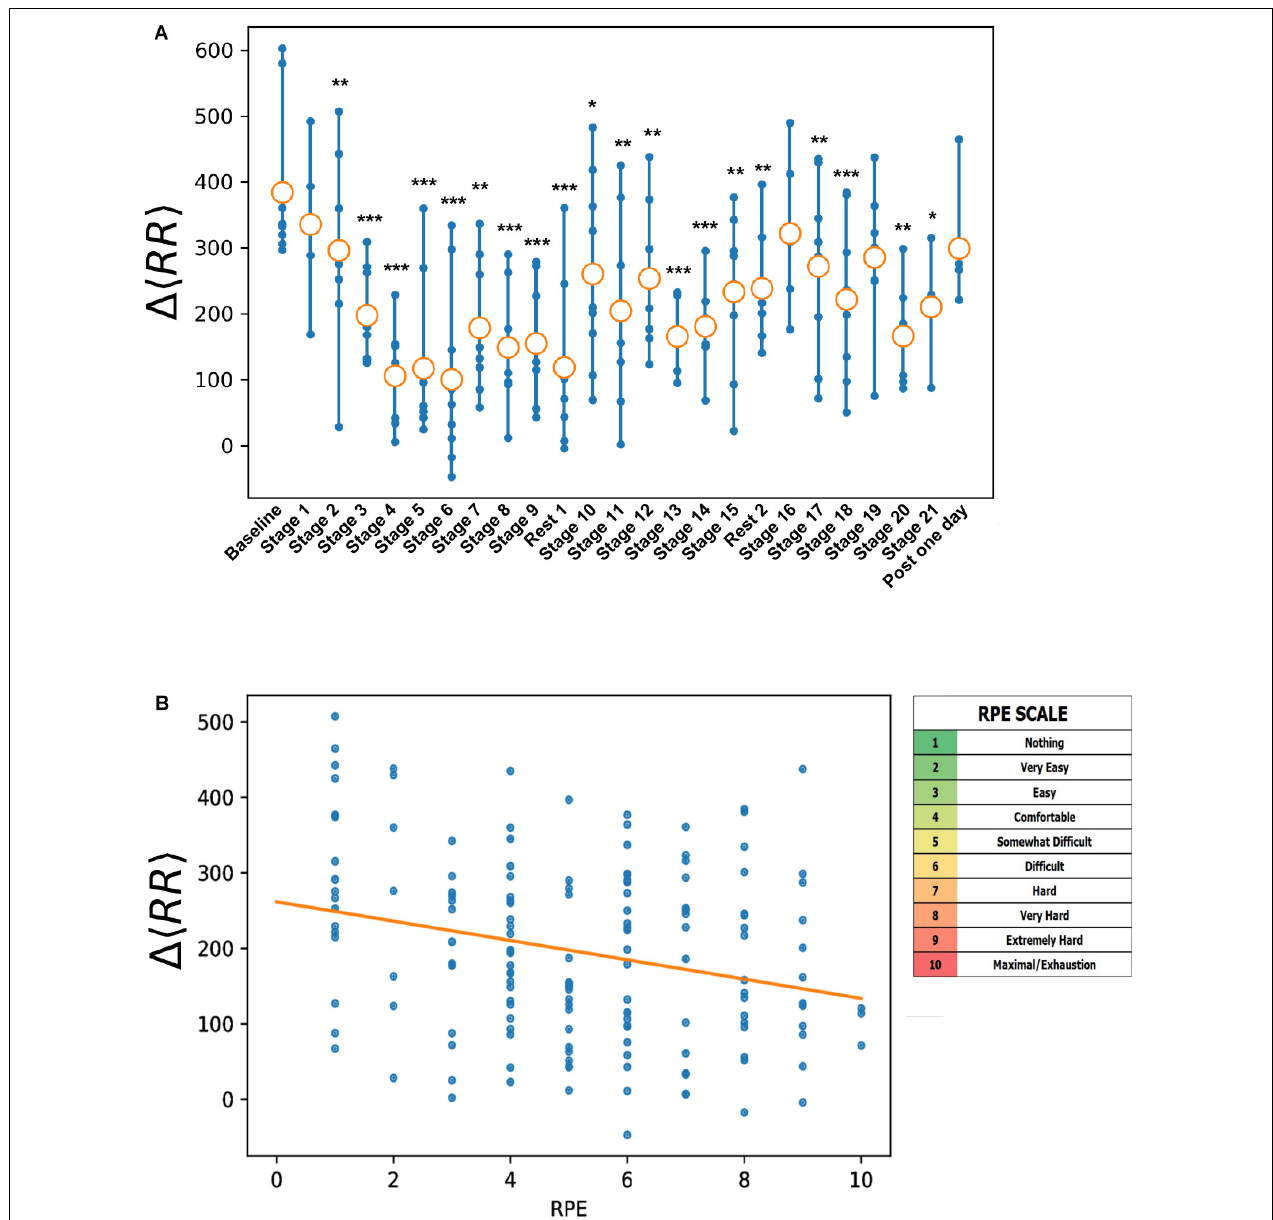
FIGURE 1 | Evolution of (cid:49) RR stage by stage (A) and with daily workload assessed through rate of perceived exertion (RPE) score on CR-10 Borg scale (B) . (A) (cid:49) RR of stage n reflect stress/fatigue induced by stage n–1. Statistical differences with baseline: * p < 0.05, ** p < 0.01, and *** p < 0.001.